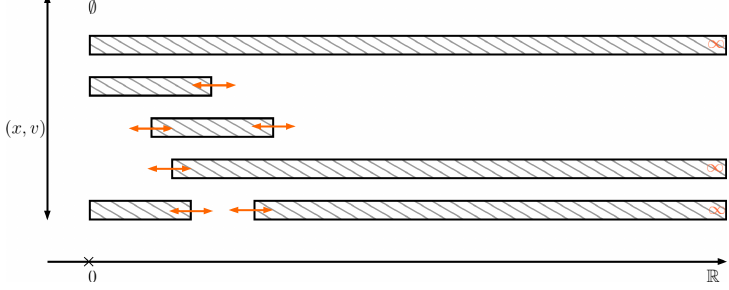
Figure 1 The mapping e is the probability measure of certain intervalles. Their number and shape depend on the arguments ( x, v ). This figure illustrates the possible situations when k = 1 and g 1 is (non-convex) quadratic in the second argument with non-vanishing quadratic